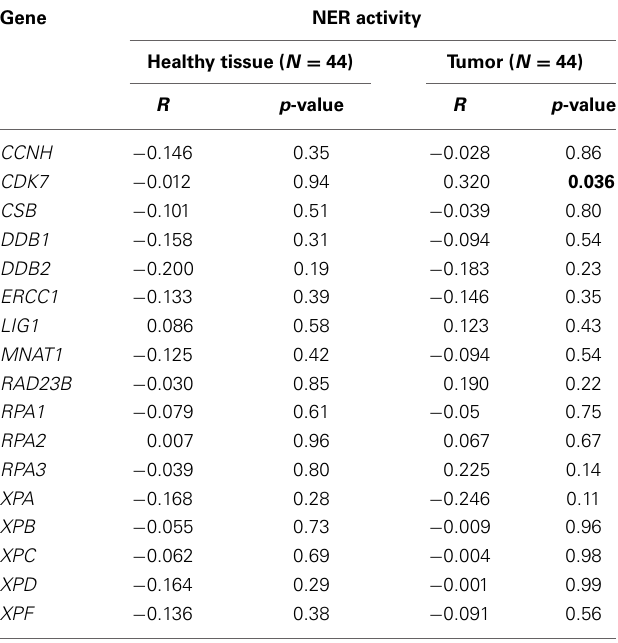
Table 2 | Correlation of expression of 17 genes involved in NER pre-incision complex with overall NER incision activity (Pearson’s correlation coefficient).